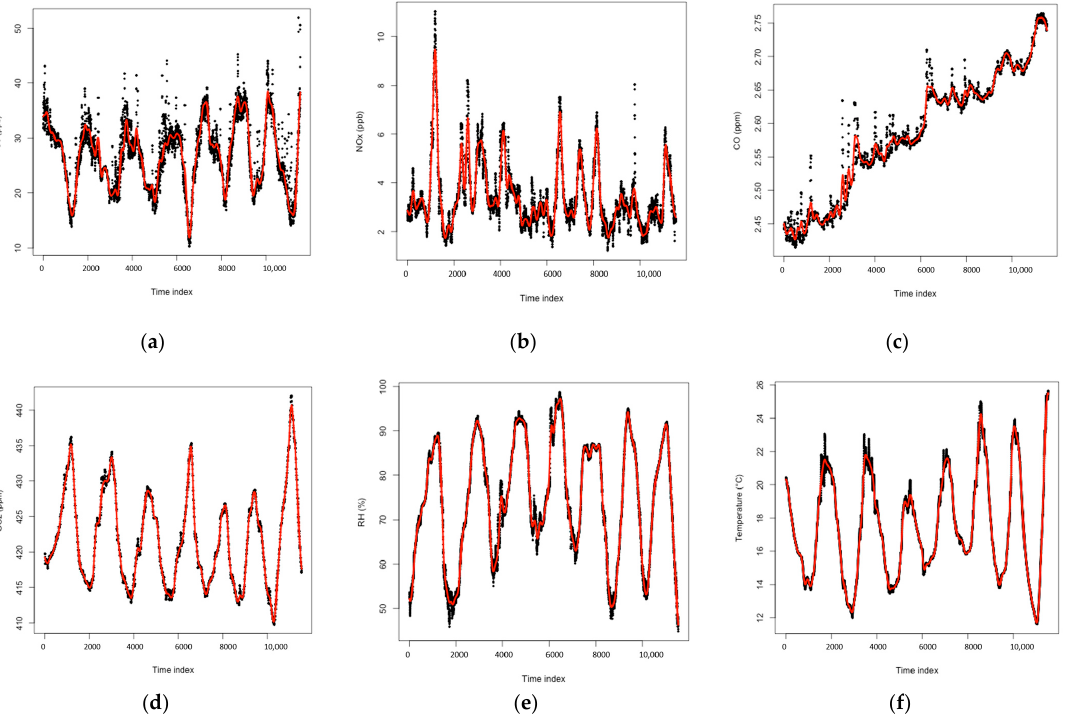
Figure 9. Environmental parameters measured in Sense-City: ( a ) O 3 (ppb), ( b ) NO x (ppb) ( c ) CO (ppm), ( d ) CO 2 (ppm) , ( e ) RH (%) and ( f ) Temperature (°C). The black and red lines show the raw and filtered data respectively.